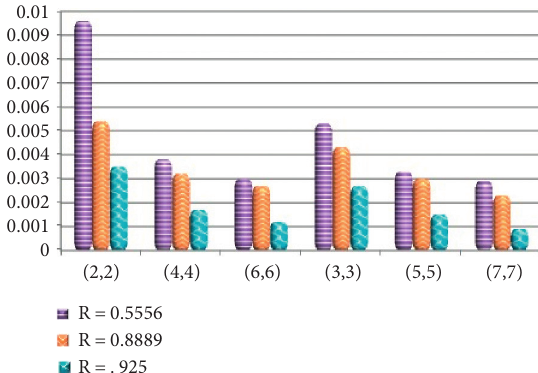
Figure 4: MSE of 􏽢 R at different values of R